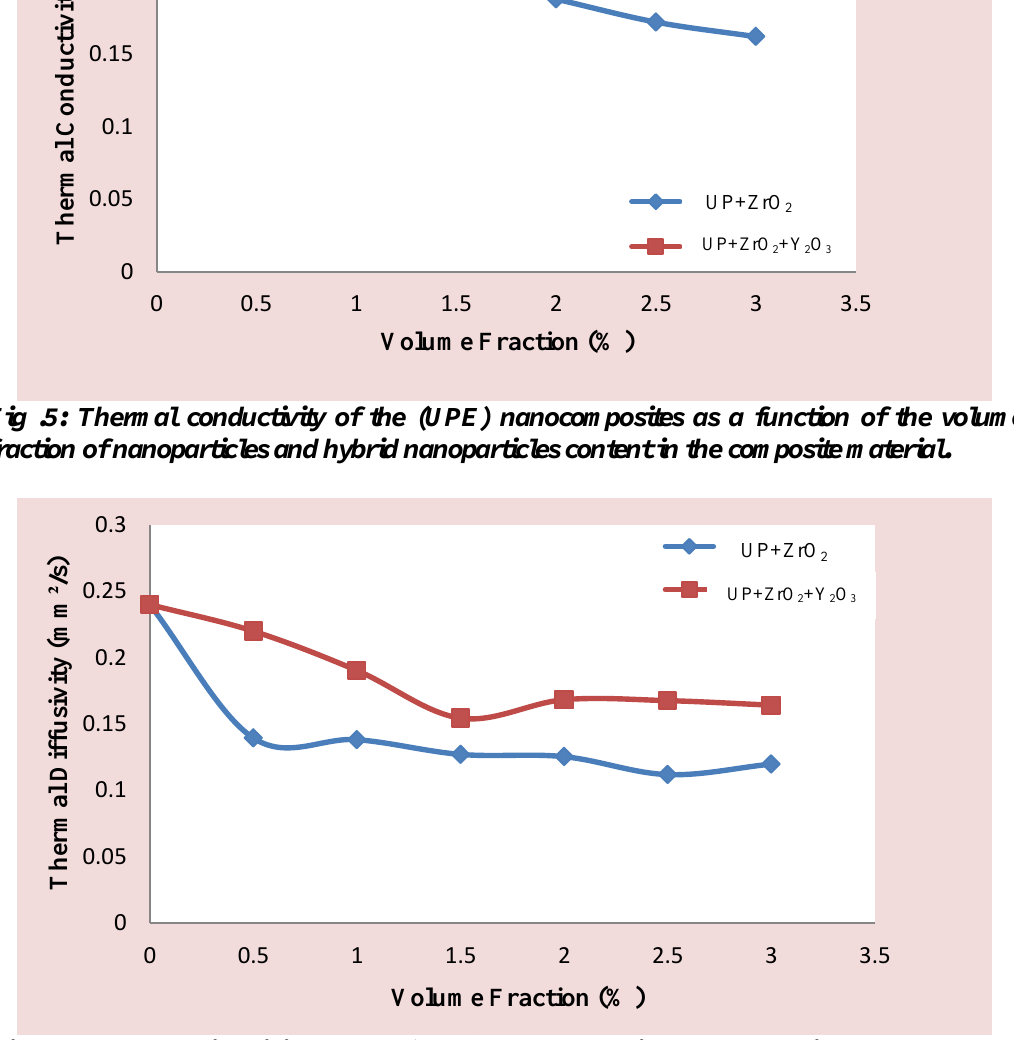
Fig .6: Thermal diffusivity of the (UPE)nano composites as a function of the volume fraction of nanoparticles and hybrid nanoparticles content in the composite